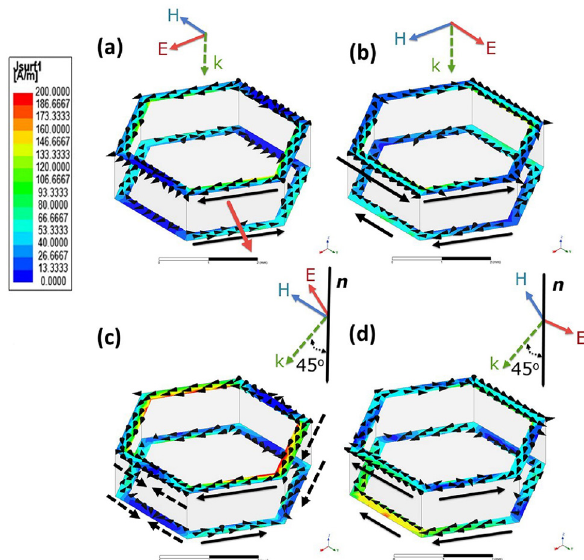
Figure4: Surficialcurrentsinducedonthemeta-glassstructuredue to EM waves at different incident polarizations and angles of incidence. (a) TE and (b) TM polarization at normal incidence. (c) TE and (d) TM polarization at 45 ° to the